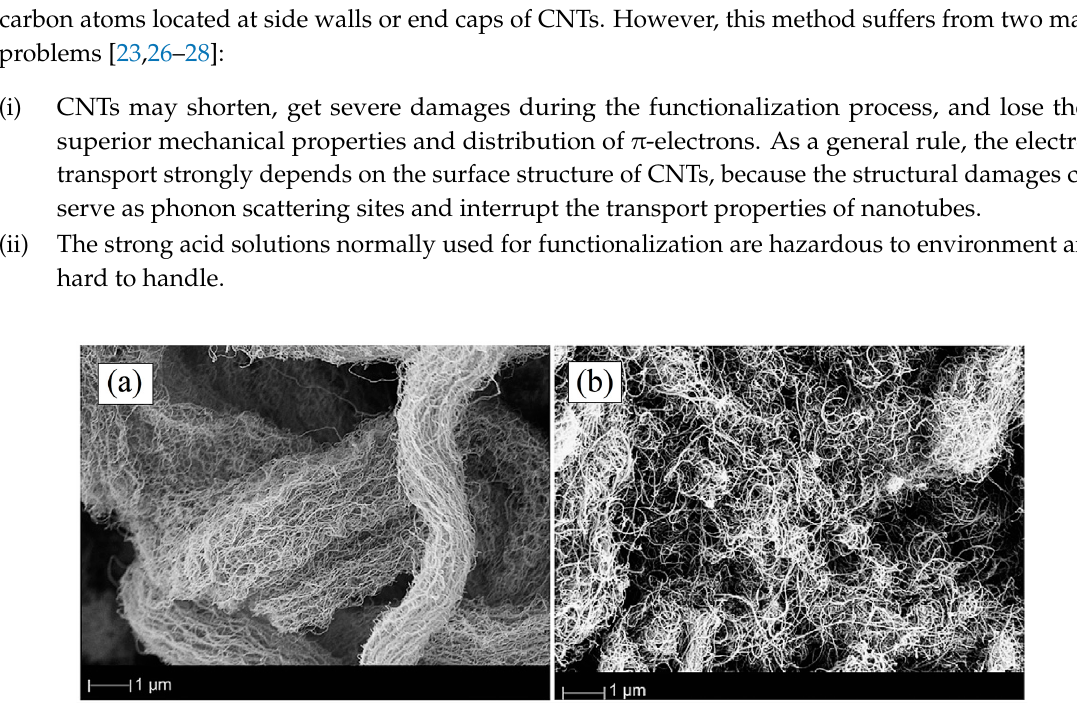
Figure 1. SEM (scanning electron microscope) images of ( a ) multi-walled carbon nanotube (MWCNT) bundles and ( b ) agglomerations [29] (Reproduced with permission from [29], Elsevier,